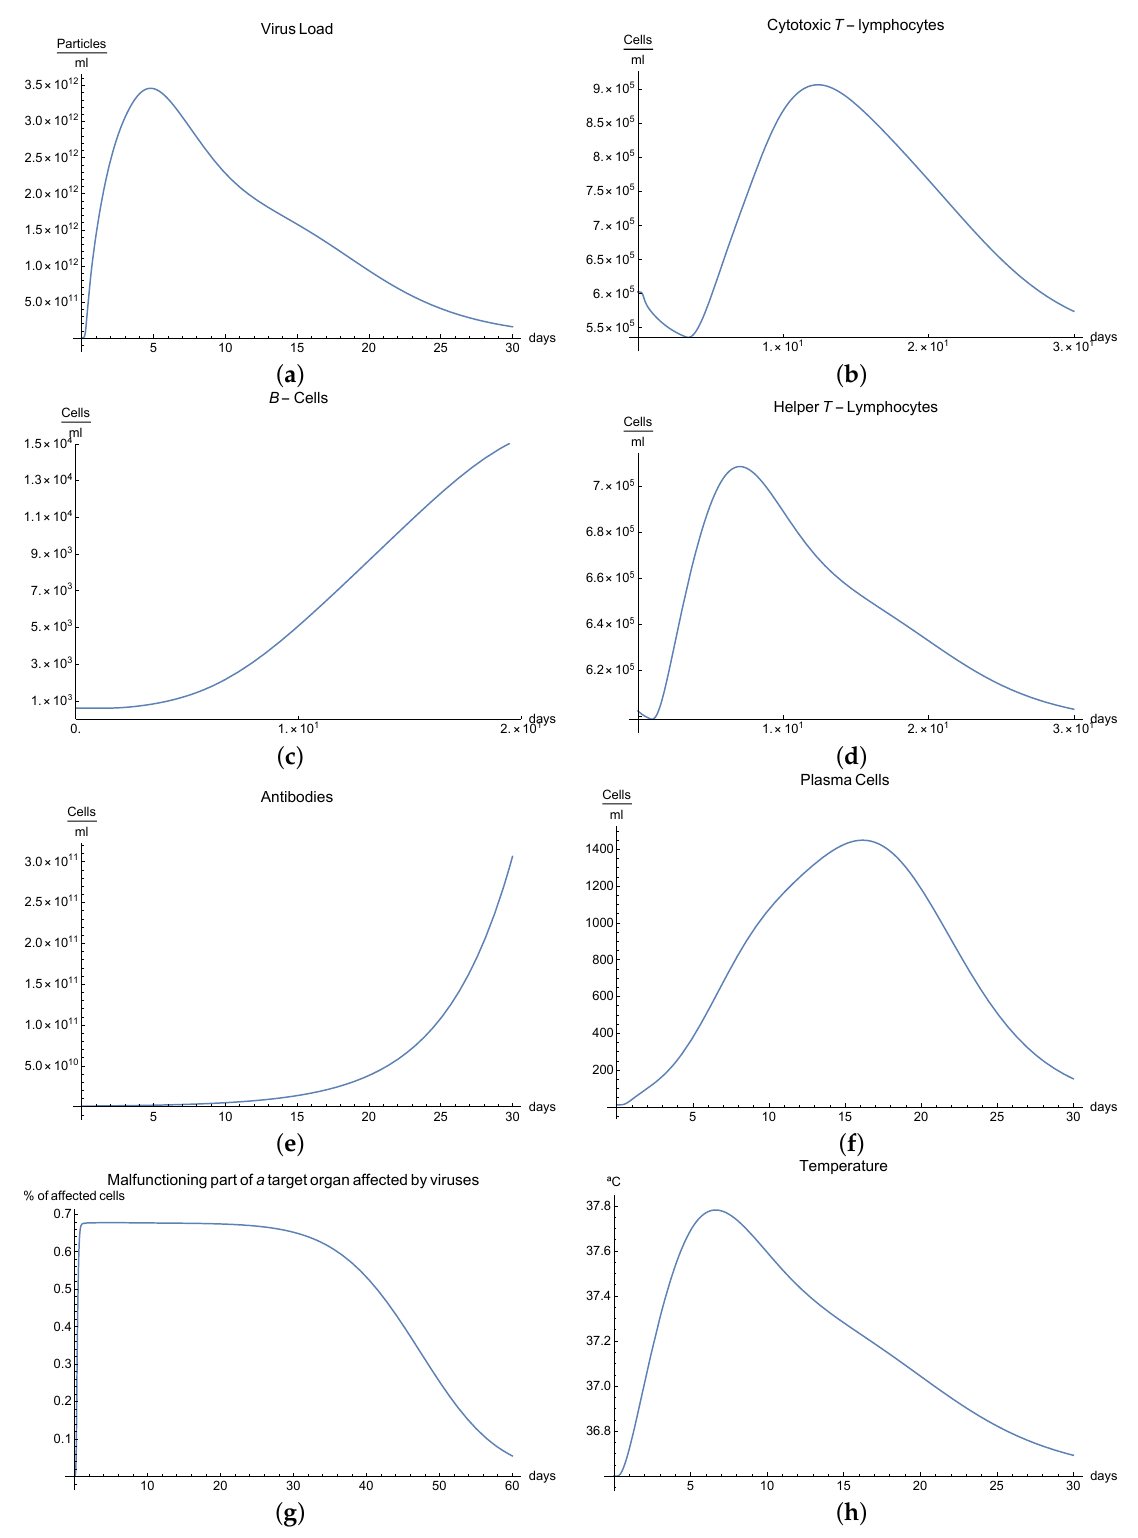
Figure 5. Numerical results of the mathematical model for the case in which the immunophysiological response of COVID-19 infection when immunotherapy using cytotoxic T-lymphocytes is applied: ( a ) the viral load V ( t ) , ( b ) the cytotoxic T-lymphocytes T e ( t ) , ( c ) the B-lymphocytes B ( t ) , ( d ) the helper T-lymphocytes class 1 T H 1 ( t ) , ( e ) the antibodies A ( t ) , ( f ) the plasma cells P ( t ) , ( g ) the malfunctioning part of a target organ affected by viruses m ( t ) , and ( h ) body temperature θ ( t ) . In all cases, the numerical results are simulated when immunotherapy using antibodies is